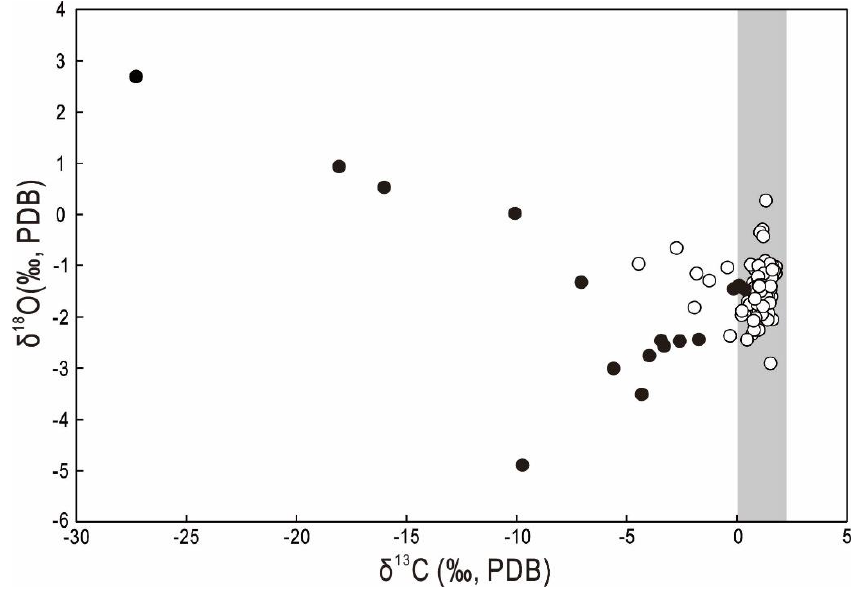
Figure 5. δ 13 C vs. δ 18 O diagram for planktonic foraminifera Globigerinoides ruber and sediment inorganic carbon. The white circles represent the stable isotopic records of planktonic foraminifera from core 2PC; black circles represent the stable isotopic records of sediment inorganic carbon from the core [78]. The gray rectangle indicates the range of planktonic foraminifera Globigerinoides ruber δ 13 C values of typical marine settings of the South China Sea [60,62].